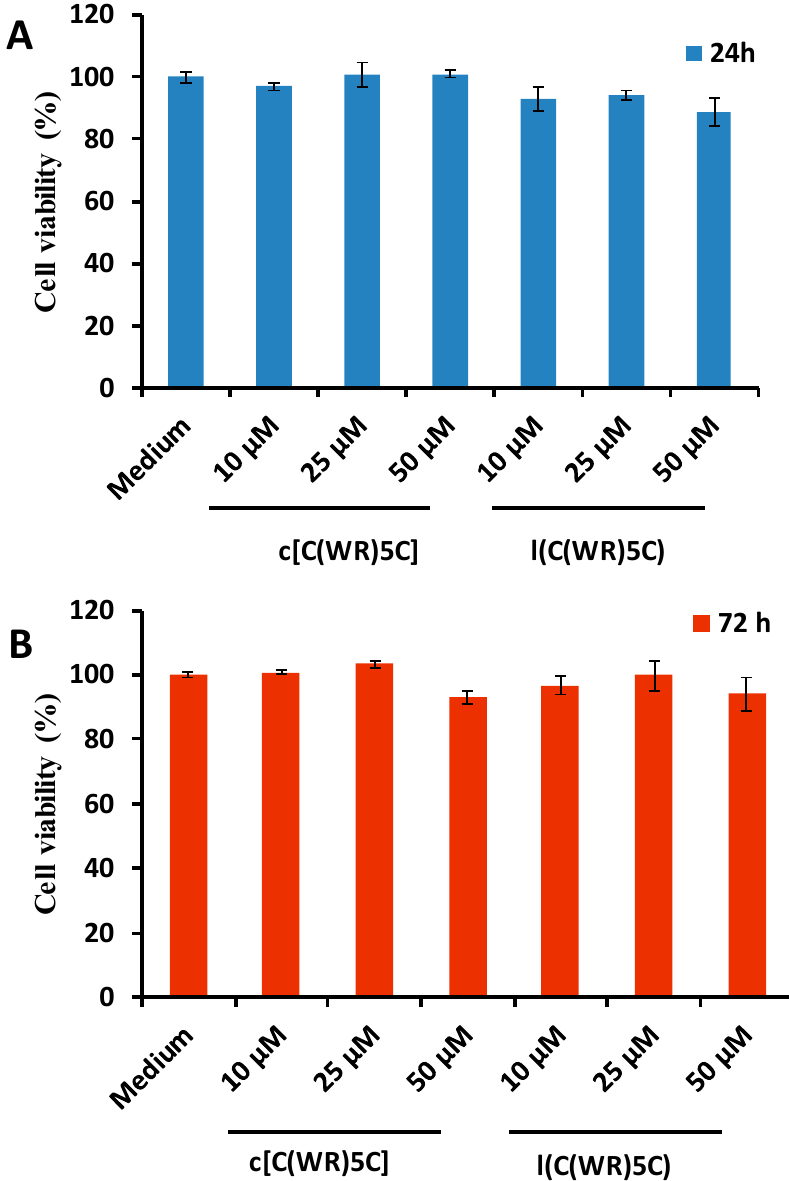
Figure 6. MTS assay of peptides (10–50 µ M) on MDA-MB-231 cell lines’ incubation at 24 h and 72 h ( n = 3) (results are not statistically significant). Error bars are SD.